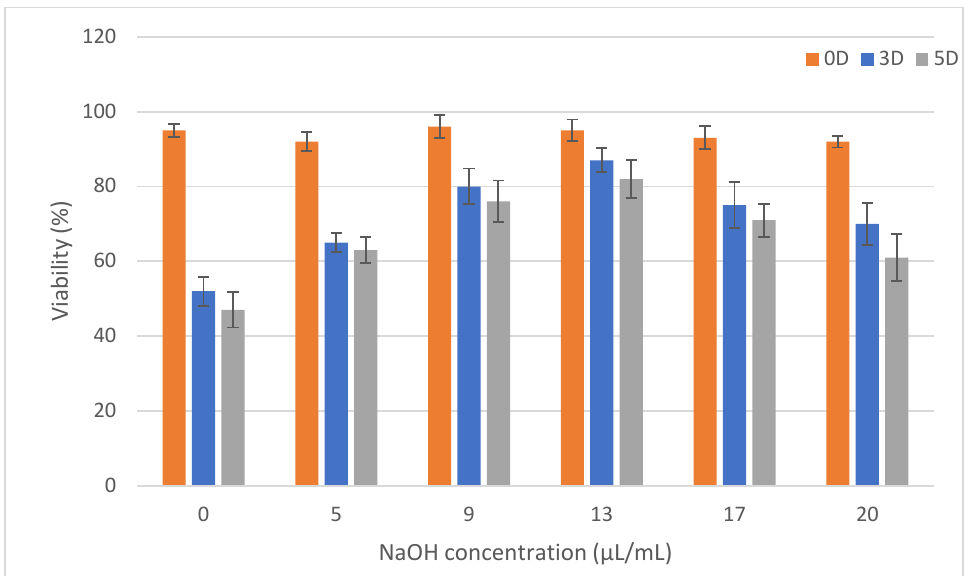
Figure 11. The viability of cells in samples after 0 (6 h), 3 and 5 days of cultivation. Data are represented as mean ± standard deviation. The data express the number of living cells as a proportion of the total number of cells. The numbers of cells were counted from pictures of live and dead cells (N = 10) at a 20-fold magnification.